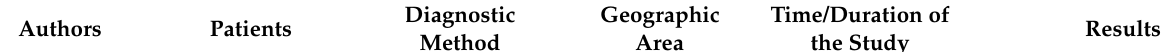
Table 3. COVID-19 and IBD in children.